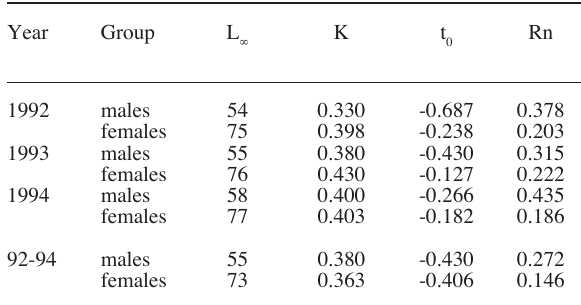
0 being adjusted for a CL